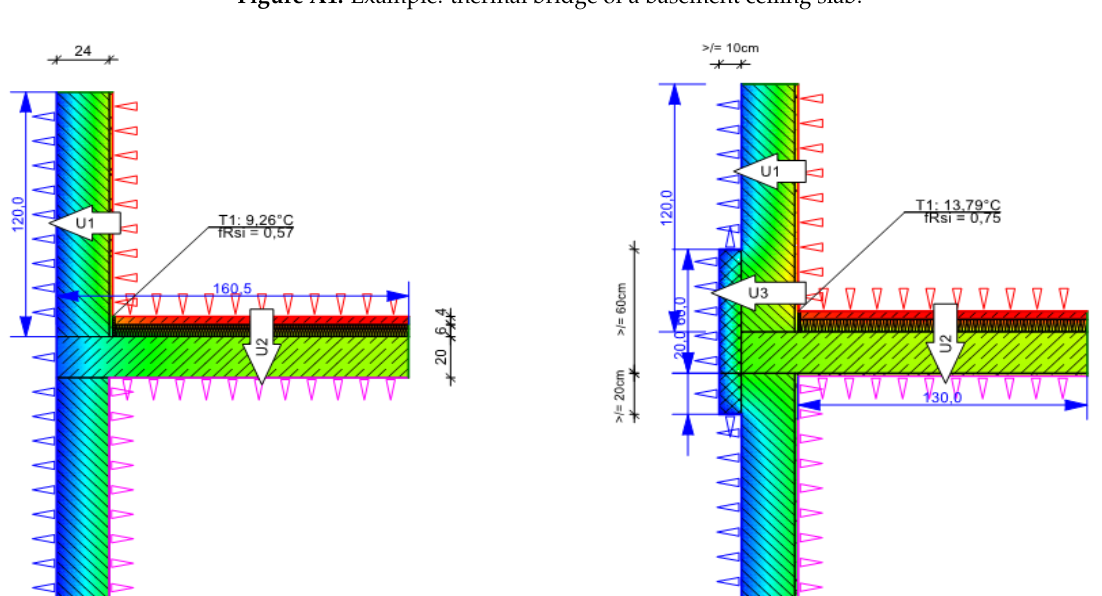
Figure A1. Example: thermal bridge of a basement ceiling slab.